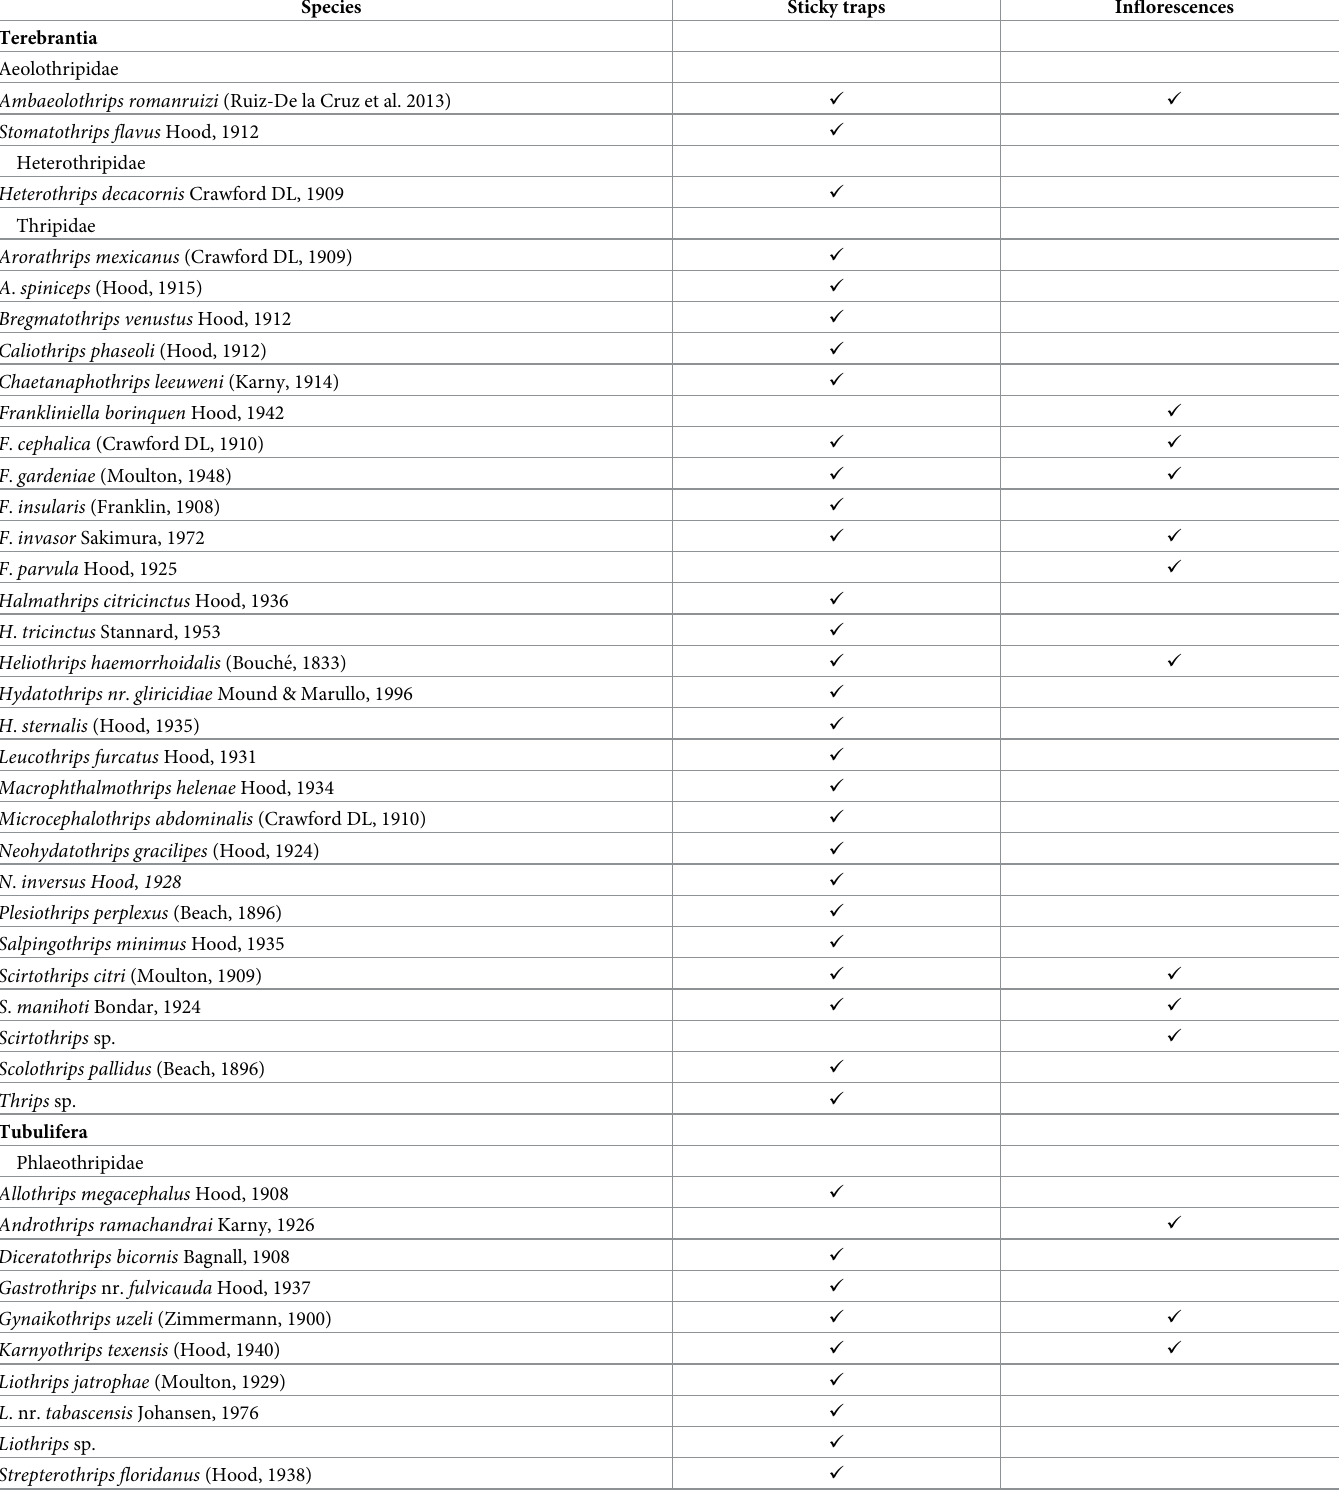
Table 1. Diversity of thrips species inhabiting Ataulfo mango agroecosystems. Species Sticky traps